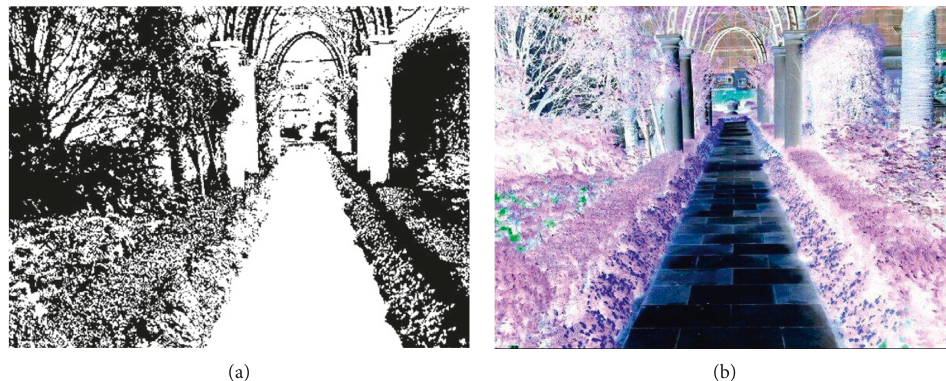
Figure 9: Examples of sustainable development garden landscape design. (a) Sketches of sustainable landscape gardens. (b) Color rendering of sustainable development garden